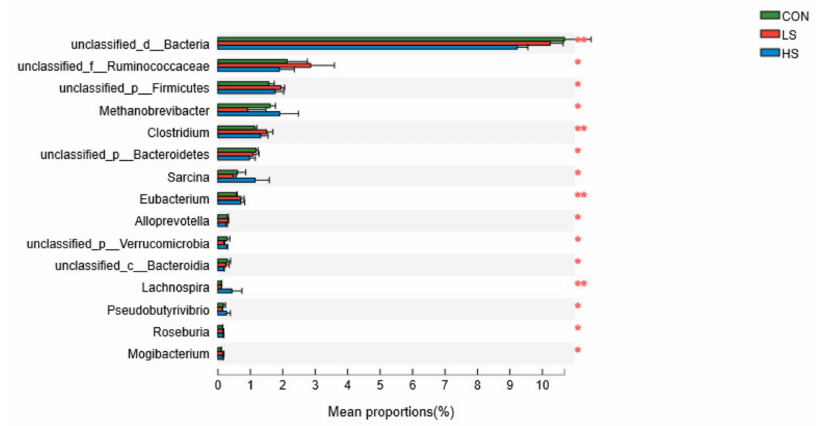
Figure 3. Effect of selenium yeast on rumen dominant bacteria at genus level (>1%; as a percentage of the total sequence). CON = basal diet; LS = basal diet + 2.4 mg/kg SY; HS = basal diet + 4.8 mg/kg SY. * p < 0.05, ** p < 0.01.